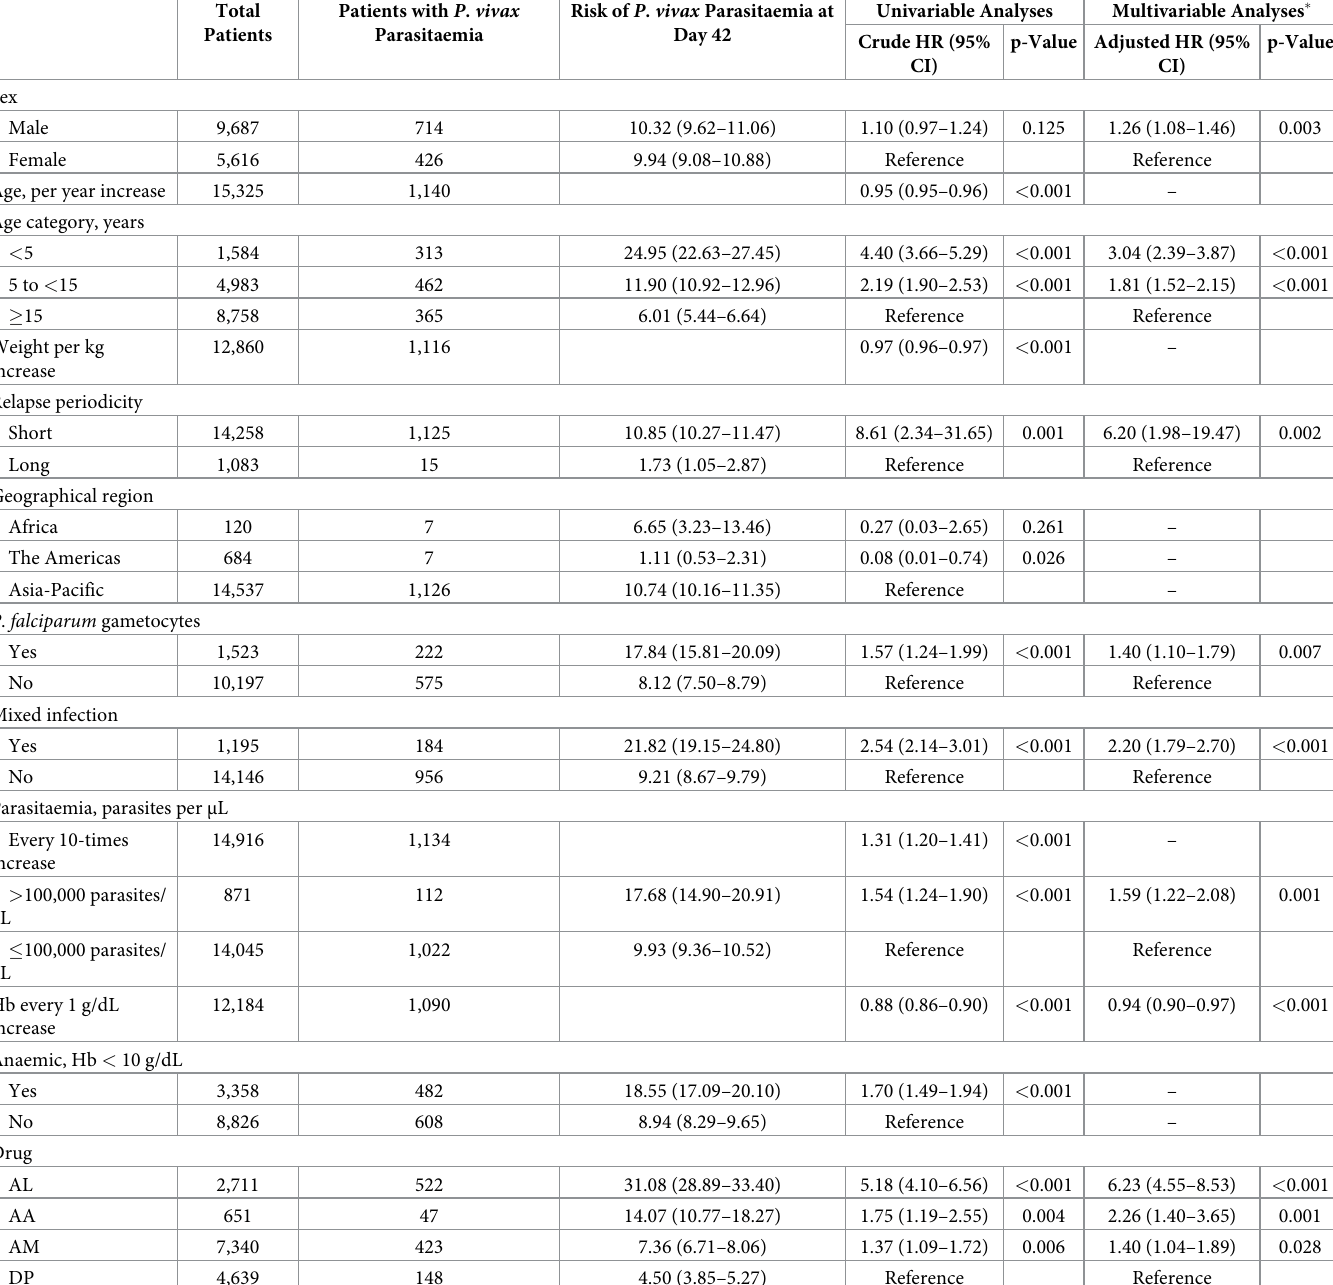
Table 2. Risk factors for P . vivax parasitaemia after falciparum infection between days 7 and 42 in patients with different ACTs.